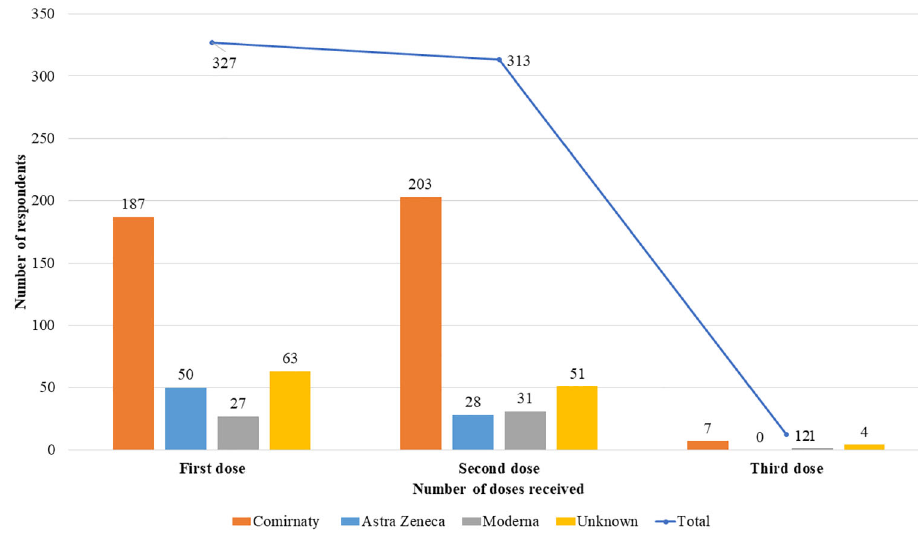
Figure 1. Number and type of vaccinations received.